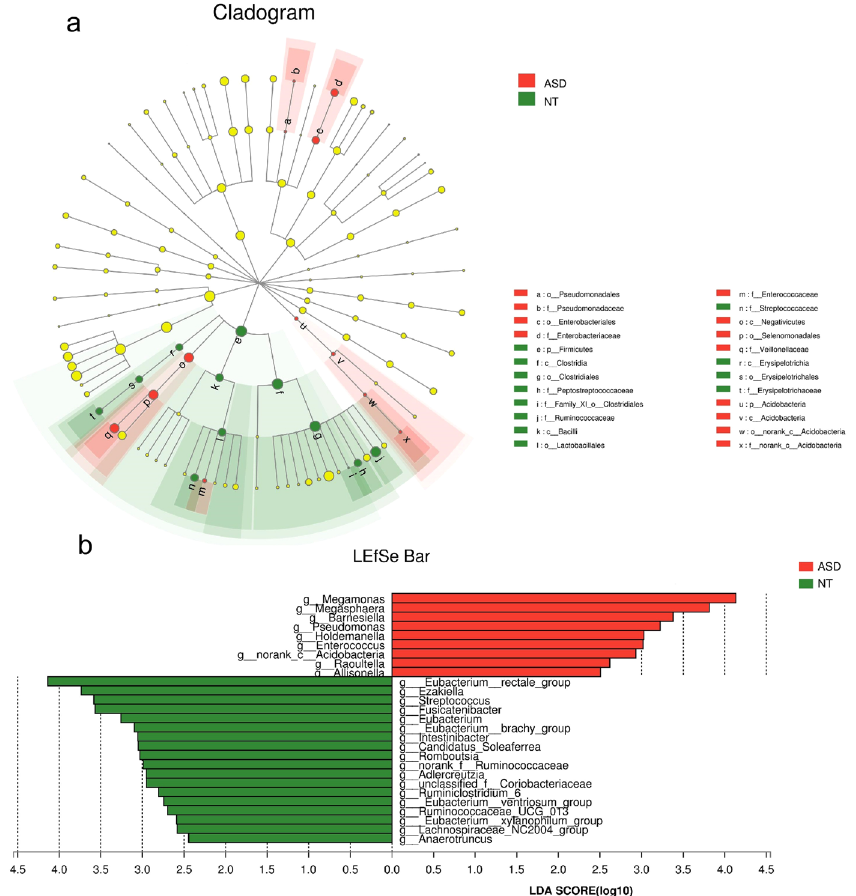
Figure 4. Differentially abundant bacterial taxa associated with the ASD and NT groups according to LEfSe analysis. The Cladogram generated by the LEfSe (from phylum to family level) and LDA scores (genus level) identify differentially abundant bacterial taxa associated with ASD and NT subjects. ( a ) Red and green dots indicate the bacterial taxa enriched in ASD and NT subjects, respectively. ( b ) Enriched bacterial taxa in ASD have positive LDA scores (red), and NT enriched bacterial taxa have negative scores (green). Only the taxa having an LDA > 2.0 are shown in the